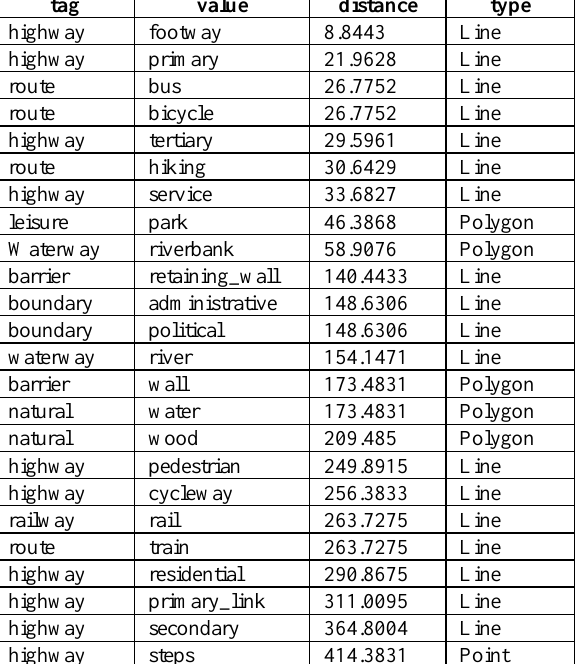
Table 6 . All TP objects in radius 500m of the registered ATM tag